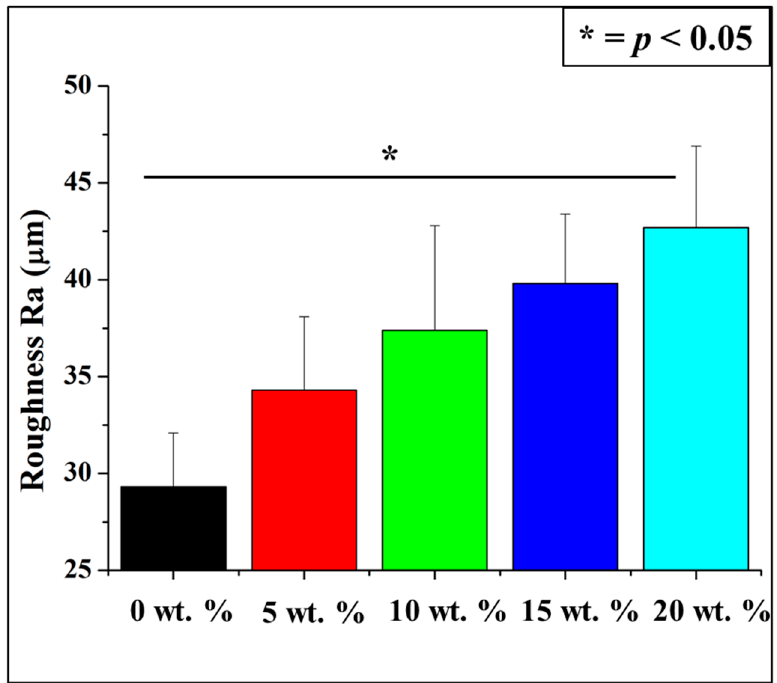
Figure 3. Surface microscopic roughness of CA/AlN composites. * = p < 0.05